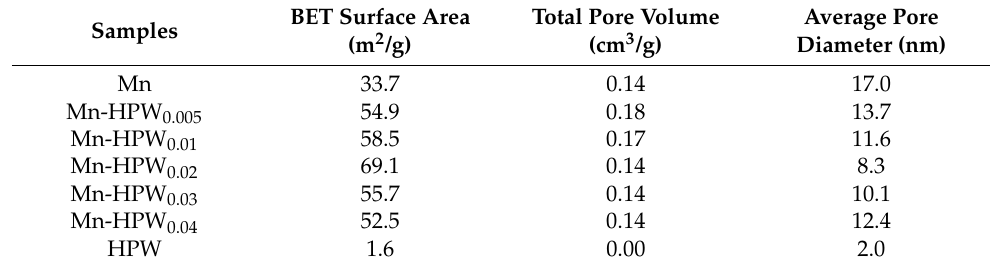
Table 1. Surface area and pore structural characterizations of the Mn, Mn-HPW x , and HPW